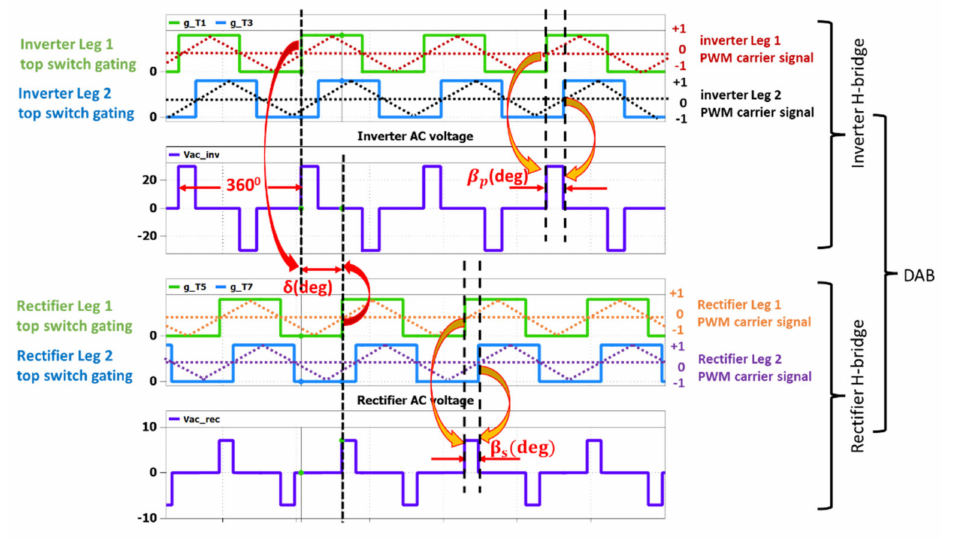
Figure 2. Inverter and rectifier AC voltage pulse generation from DAB TPS PWM modulation.